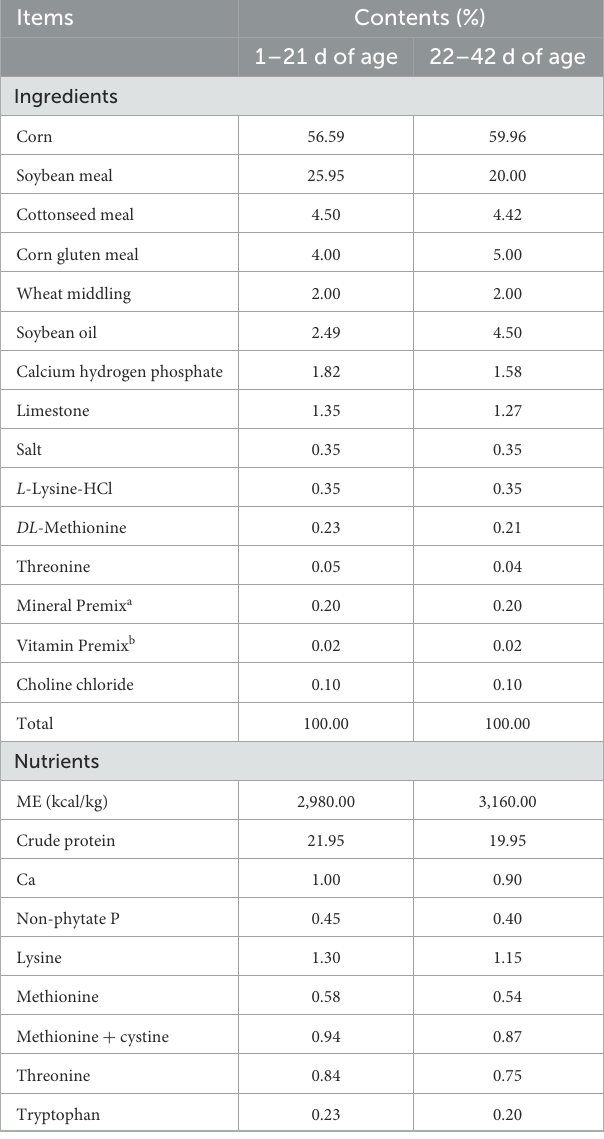
TABLE 1 Composition and nutrient levels of basal diet in the two phases of trial (% as fed